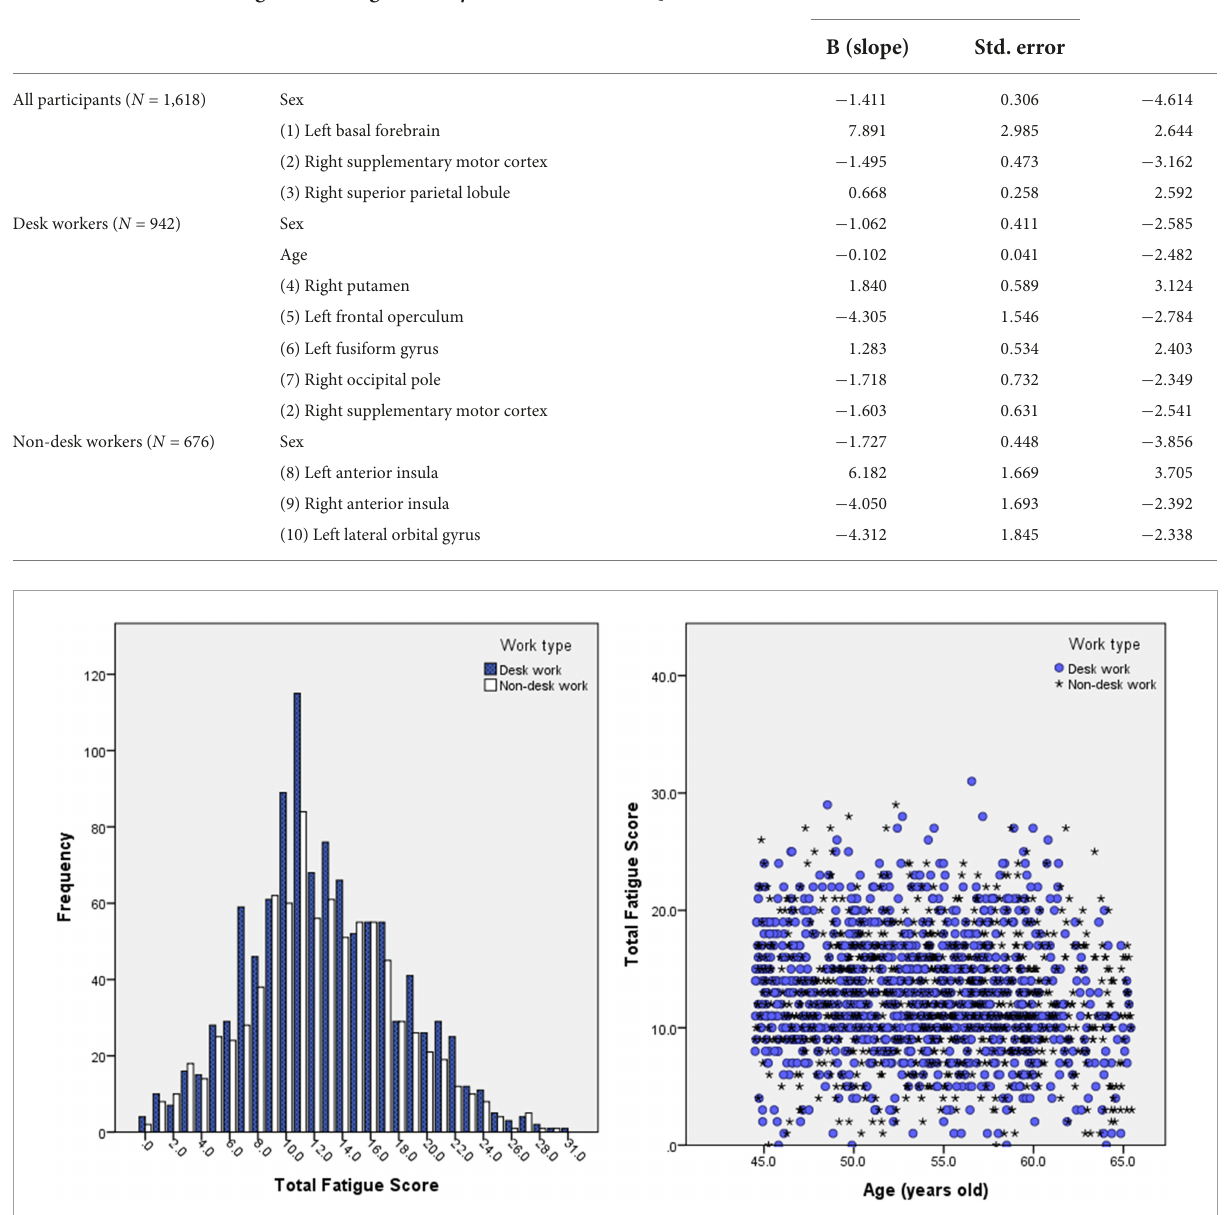
TABLE 2 Linear regression (stepwise-forward) analysis results for all participants, desk workgroup, and non-desk workgroup, with CFQ score as the target variable and age, sex, work type, and volume of brain regions as the independent variables. Parameters and brain regions that significantly correlates with CFQ scores